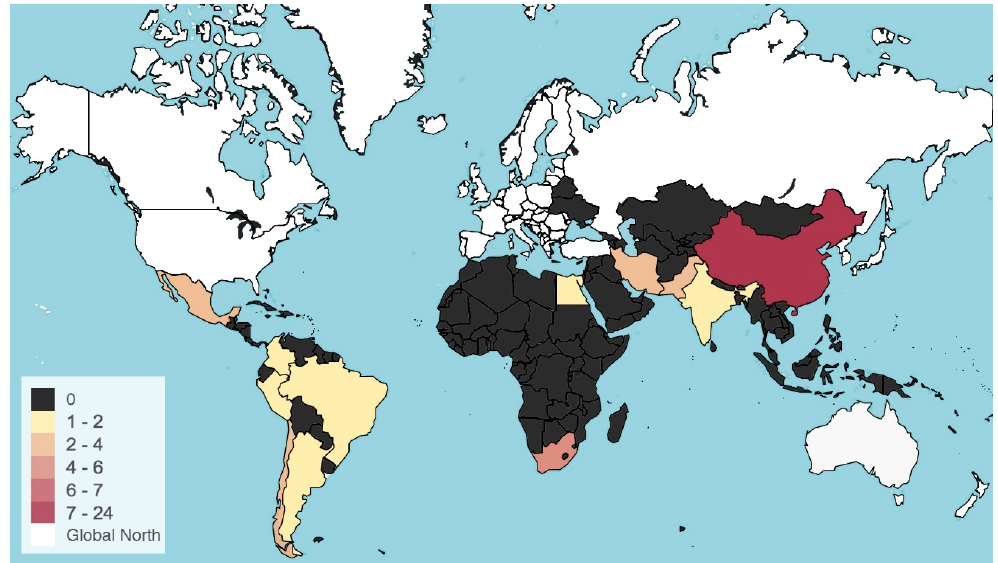
Figure 2. Number of articles studying each Global South country. Map created with heatmapper [115].